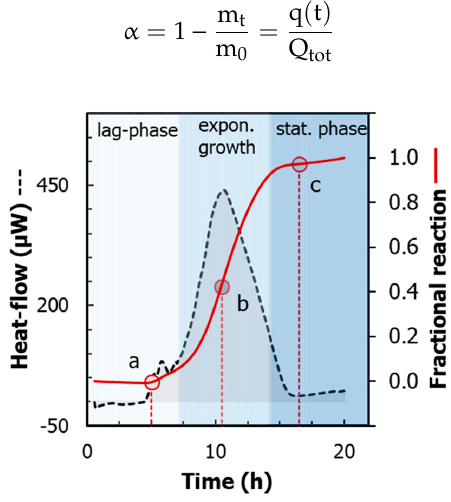
Figure 1. Heat-flow traces of E. coli , growing on yeast broth at pH 7.2 and 37 °C in the presence of air in the headspace of the glass ampoule (dashed line). Heat evolved during growth (solid line) was obtained by integrating the area delimited by the heat-flow profile. Red circles indicate, respectively: ( a ) onset time of the exponential growth; ( b ) maximum growth rate; ( c ) total heat. Shown also with different shades of color intensities are the distinct steps of microbial growth, respectively, lag phase, exponential growth, and stationary phase.